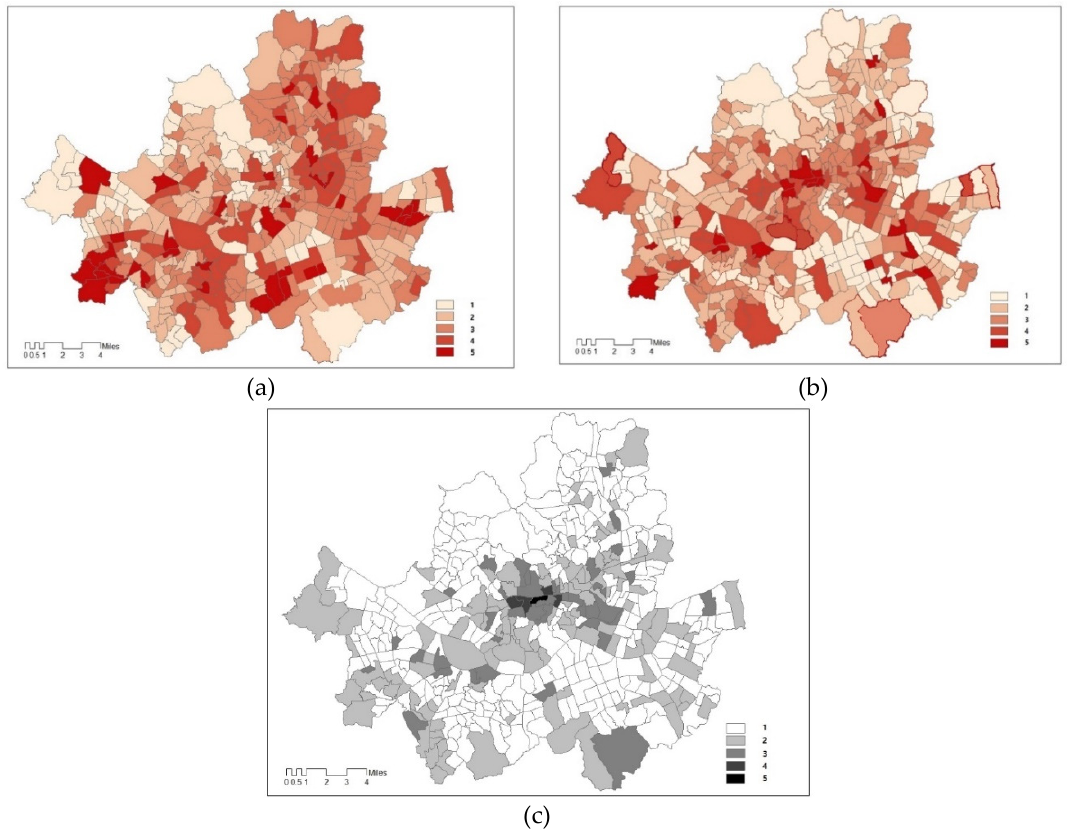
Figure 5. Vulnerability to heat flux and temperature in relation to mortality rate. ( a ) Temperature Vulnerability index; ( b ) Sensible heat vulnerability index; ( c ) Heat-related illness mortality rate. Note: Clustering Class (range): 1 (0~0.08), 2 (0.08~0.32), 3 (0.32~0.49), 4 (0.49~0.76), 5 (0.76~1.00). Because there are none values ( = 0) on mortality rate in communities, the range of the both sensible heat and temperature vulnerability was classified using hierarchical clustering to compare with the death rate.